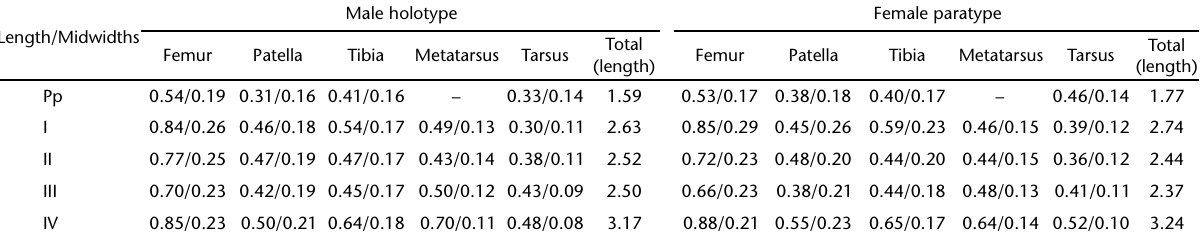
Table II. Masteria emboaba sp. nov. Male holotype and femlale paratype (MNRJ 4540). Length and midwidths of right legs and palpal segments. Male holotype Female paratype Length/Midwidths Total Femur Patella Tibia Metatarsus Tarsus Femur Patella Tibia Metatarsus (length)